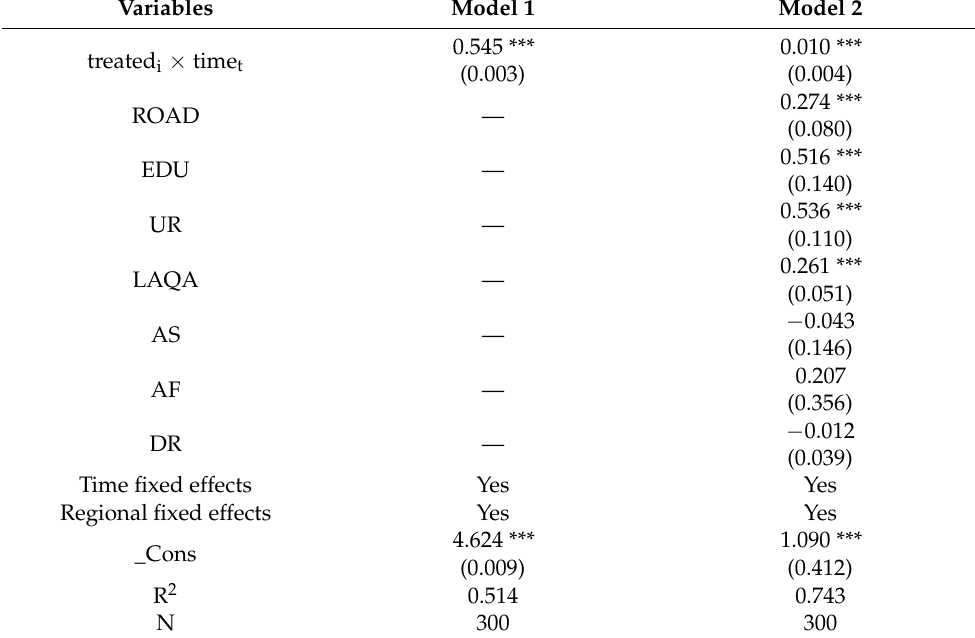
Table 3. Baseline regression